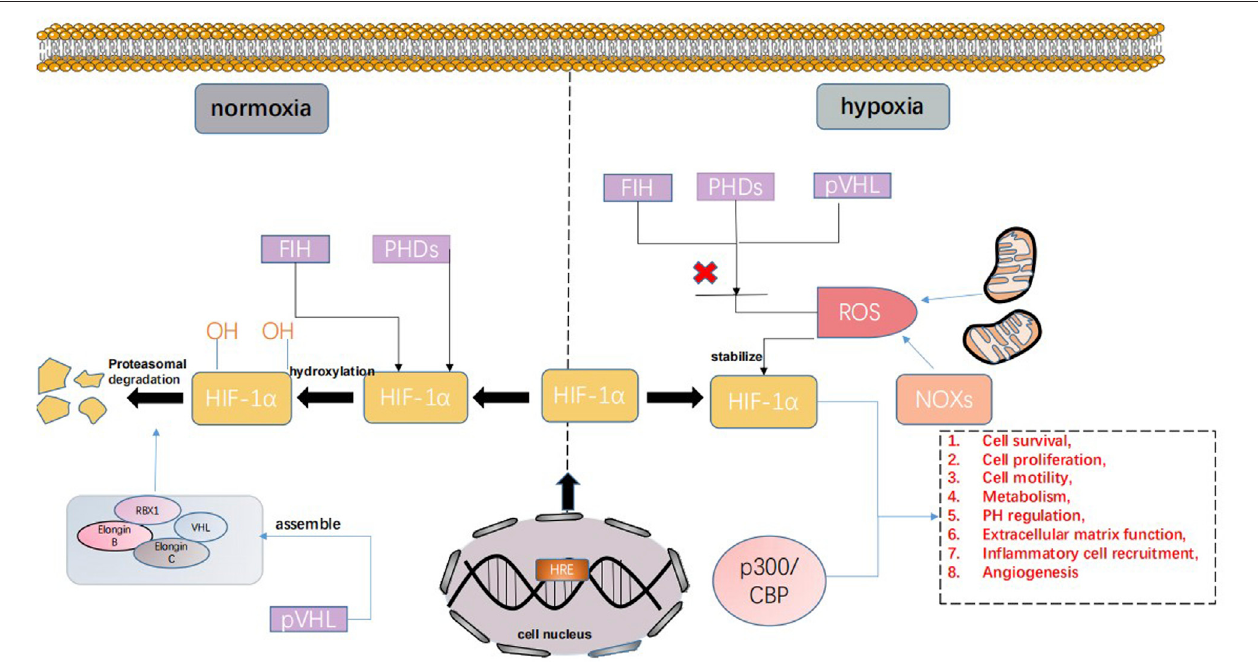
FIGURE1| HIF canbeexpressed indifferentways under normoxia and hypoxia.Undernormoxic conditions, thehypoxia-inducible factor-1 α subunit canbind the vonHippel-Lindautumorsuppressorgeneproduct (PVHL).pVHLmediatestheubiquitin – proteasome, whichiscomposedofRBX1,ElonginB,ElonginC,and VHL.The ubiquitin – proteasome pathway rapidly degrades HIF. In contrast, under hypoxic conditions, the hypoxia-inducible factor-1 α subunit becomes stable and interacts with coactivators, such as p300/CBP, and the transcriptional activity of hypoxia-inducible factor-1 α is enhanced. Under hypoxic conditions, it has become the main regulator of many hypoxia-induced genes involved in cell survival, proliferation, exercise, metabolism, pH regulation, extracellular matrix function, in fl ammatory cell recruitment, angiogenesis, etc.